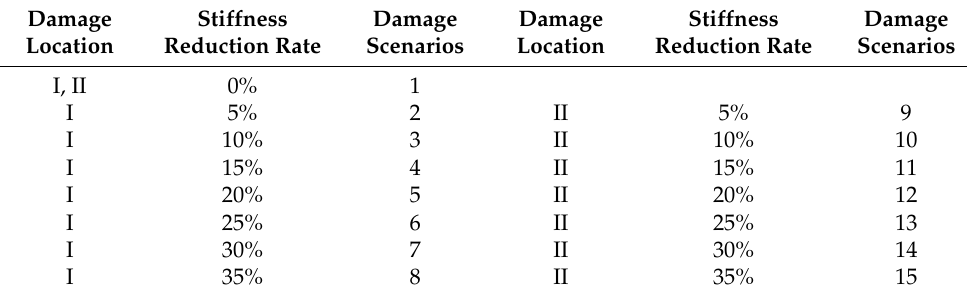
Table 1. Damage scenarios of the CCRFB.